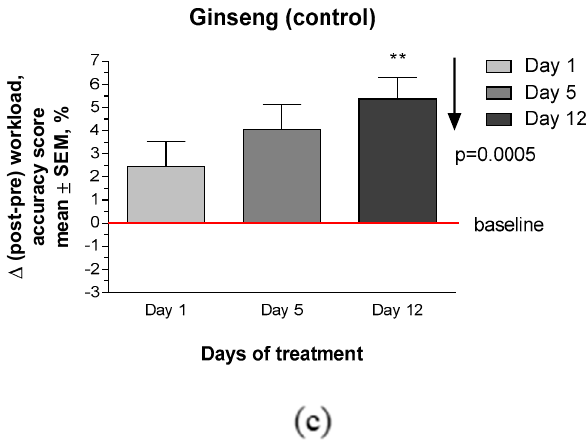
Figure A5. Difference between post- and preworkload accuracy scores (mean ± SEM, Y -axis) in memory test at Days 0, 1, 5, and 12 in ( a ) placebo, ( b ) ginseng HRG80, and ( c ) ginseng control treatment groups. Change significance shown by symbols * p < 0.05, ** p < 0.01, *** p < 0.001; ns, not significant. Within-group improvement of mental performance on stress background at end of treatment (Day 12 vs. Day 0) was observed during treatment with ginseng groups (p < 0.05), but not during treatment with placebo ( p > 0.5).